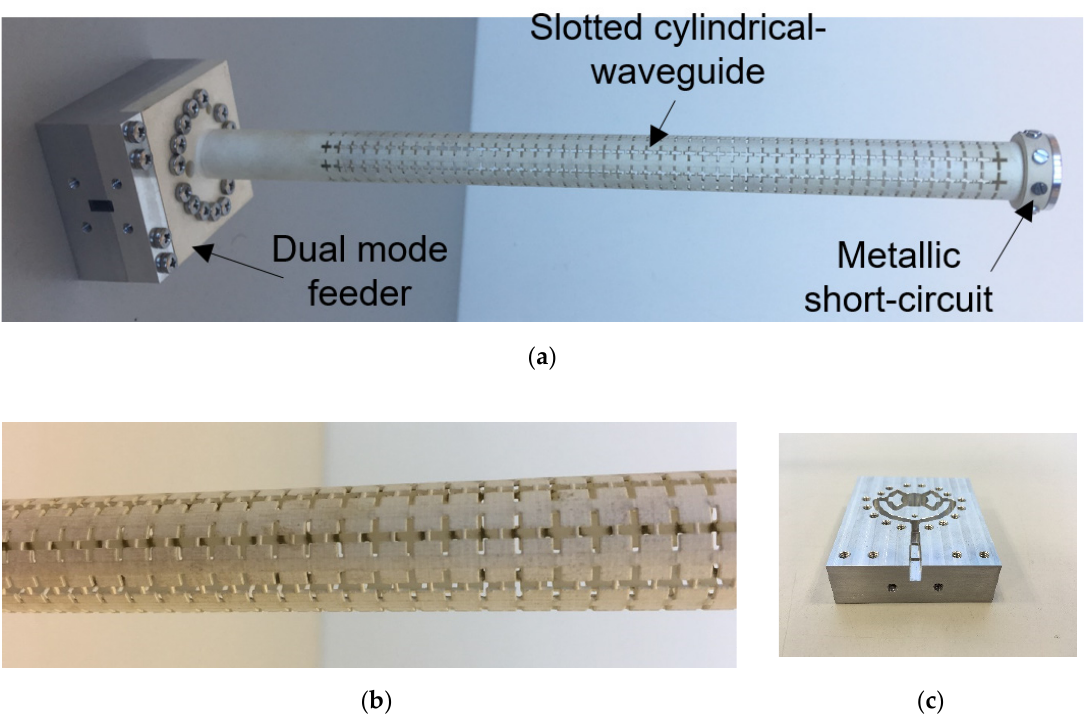
Figure 12. Photographs of the conformal array antenna manufactured by SLA + spray metallization: ( a ) whole antenna prototype; ( b ) slotted cylindrical waveguide detail; and ( c ) dual-mode feeder.